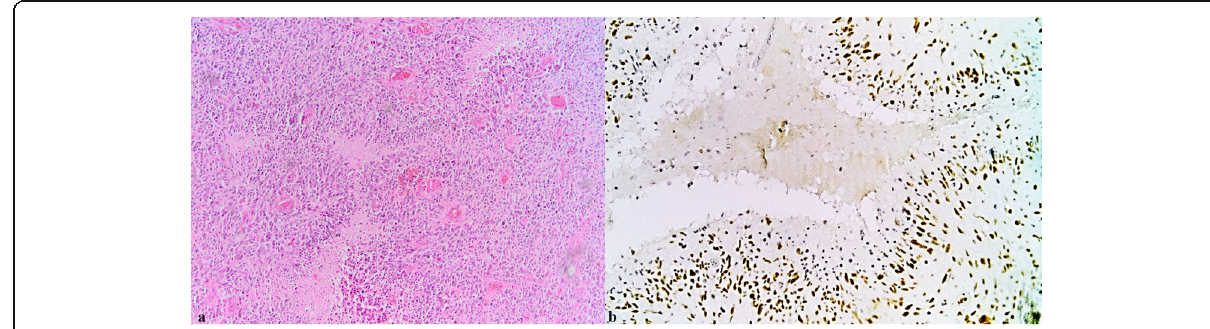
Fig. 1 a Necrosis is one of the histologic hallmarks of glioblastoma. Necrotic areas are usually seen in a serpentine or geographic pattern. Tumour cells migrate away creating a moving wave of palisading cells around the necrotic areas. (HE 10X) b Immunohistochemical expression of p-Stat3Y705 at the nuclear level. The cells are positive mainly in areas with hypoxia located around the necrosis (20X)